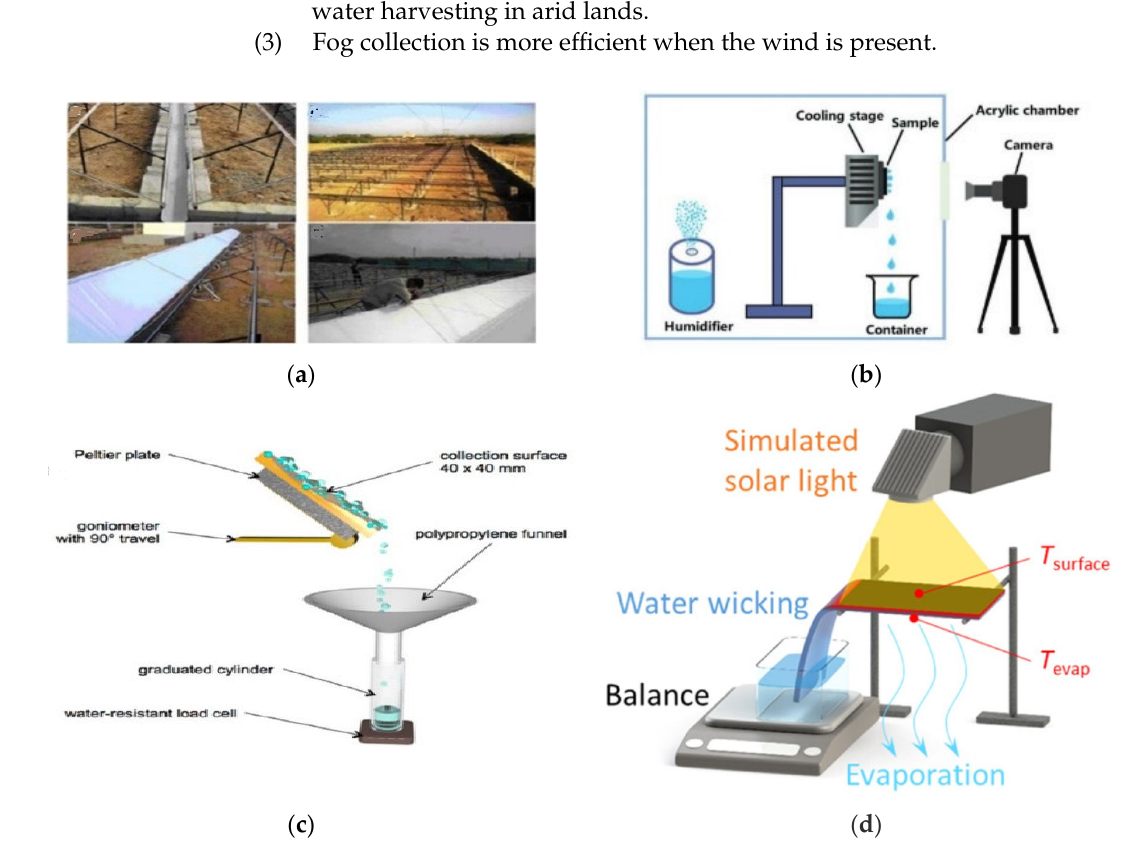
Figure 2. Different types of dew water harvesting technology. ( a ) Water Harvesting Plant for Dew Bottling [27]. ( b ) Hybrid Surfaces for Improved Dew Collection [29]. ( c ) Dew water collection [22]. ( d ) Solar driven freshwater harvesting [30].